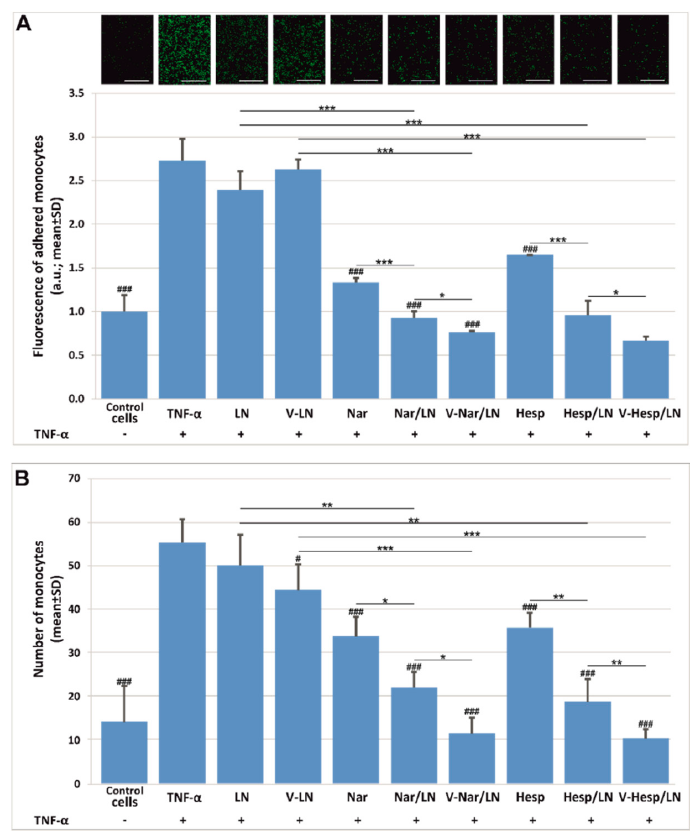
Figure 5. Functional role of VCAM-1 targeted flavonoid-loaded nanoemulsions in the reduction of monocyte adhesion ( A ) and transmigration ( B ) to/through TNF- α activated EA.hy926 cells, as compared with the same concentration of free flavonoids (50 µM). Results are presented as means ± standard deviation (S.D.) of a representative experiment from three experiments performed in triplicates; * depicts comparisons between the groups; # are significances relative to TNF- α , * and # represent p < 0.05; ** p < 0.01; *** and ### p <